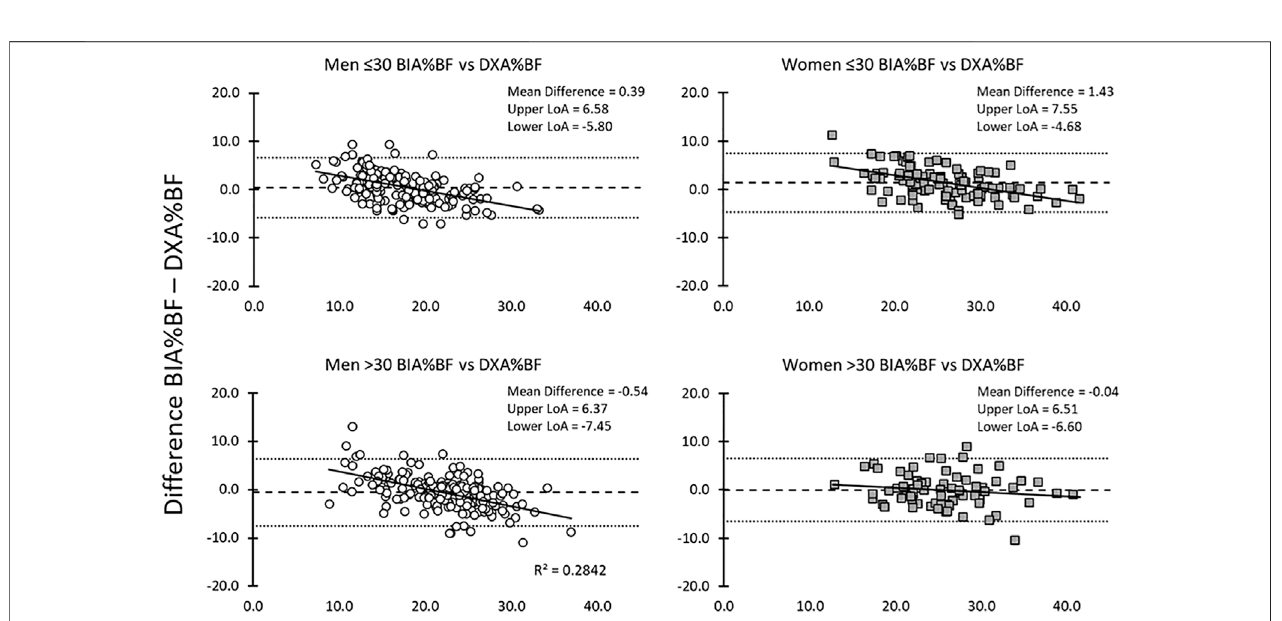
Frontiers in Physiology |